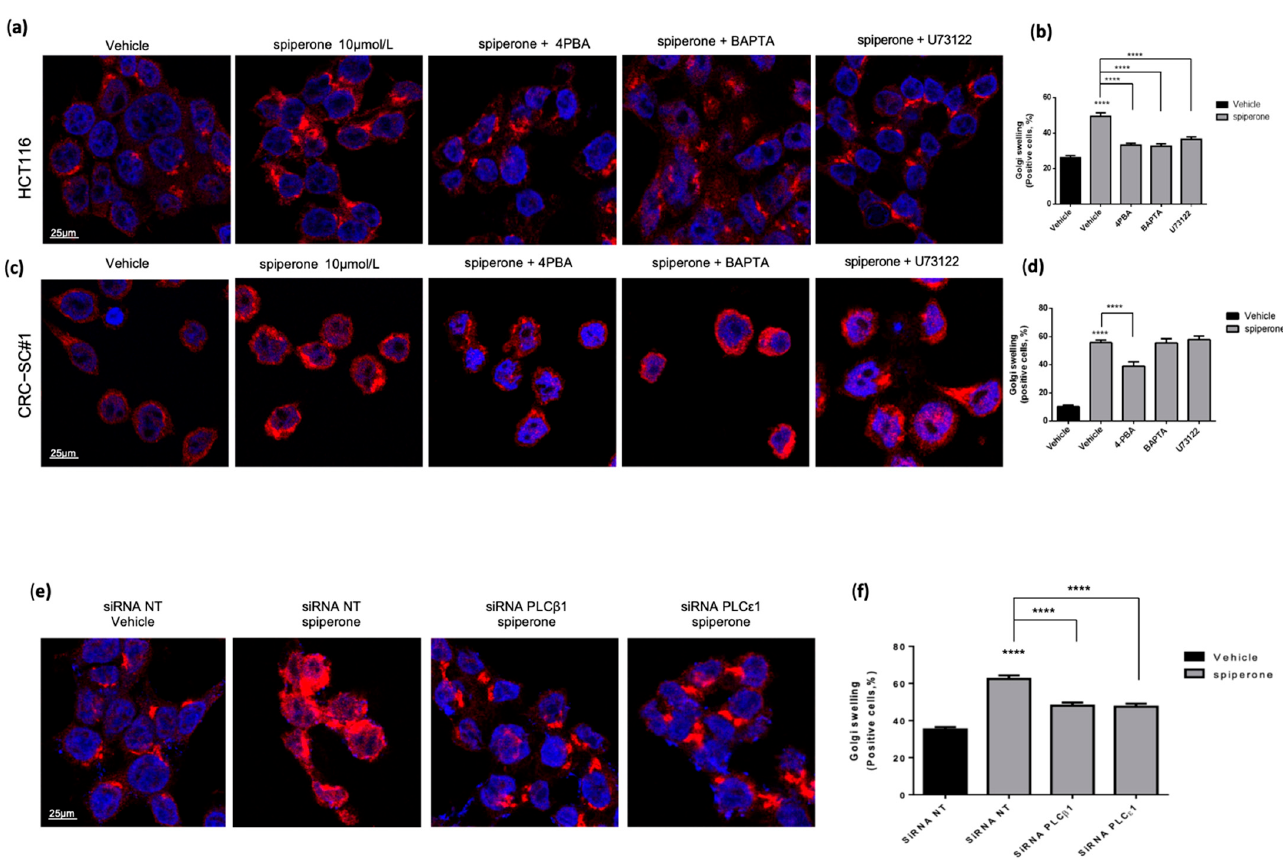
Figure 13. Spiperone induces swelling of the Golgi apparatus (GA). The effect of co-treatment with spiperone and 10 μ mol/L BAPTA-AM, 1 μ mol/L U73122, and 10 μ mol/L 4-PBA on GA morphology was evaluated via confocal microscopy in HCT116 cells and CRC-SC#1 cells. The GA was stained using anti-GOLGIN 97 primary antibody and Alexa Fluor-546 secondary antibody; nuclei were stained using DAPI ( a , b ). Histogram showing the ratio of the number of cells presenting GA swelling to the total number of cells in HCT116 cells ( c ) and CRC-SC#1 cells ( d ). Representative images of the effects of spiperone treatment on GA morphology in HCT116 cells silenced for PLC β 1 and PLC ε 1 ( e ). Histogram showing the ratio of the number of cells presenting GA swelling to the total number of cells ( f ). Data are presented as the mean ± SD from three independent experiments performed in triplicate. ****: Student’s t -test p < 0.0001.